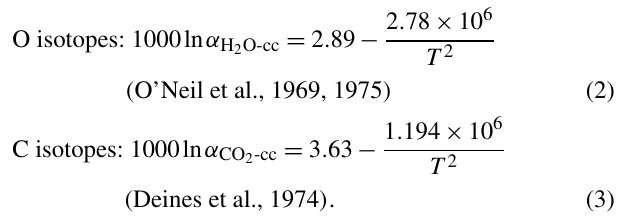
Figure 6. (a) Laminated calcite vein from location 1–4 and the associated U–Th dates (samples JK15HR110 and JK15HR111). The hand specimen (left) and plane-polarized photomicrograph (right) are shown. Note the calcite-cemented brecciated sandstone forming the vein wall. The laminated calcite vein shows at least four episodes of calcite precipitation. The calcite cement in the wall breccia is 288ka and the first lamination growing on the vein wall is 86ka. (b) Laminated calcite vein from location 1–2 that is hosted in marine limestone. U–Th dates (JK15HR27 and JK15HR35) are shown on the hand specimen. The dates indicate growth outward from the limestone wall from 113 to 86ka. Multiple dense lamina- tions are visible in the hand sample, and the plane-polarized pho- tomicrograph shows that these are constructed of fibrous calcite crystals that terminate at discrete boundaries. The outermost (86ka) layer is characterized by higher porosity vuggy calcite crystals sug- gestive of growth into free